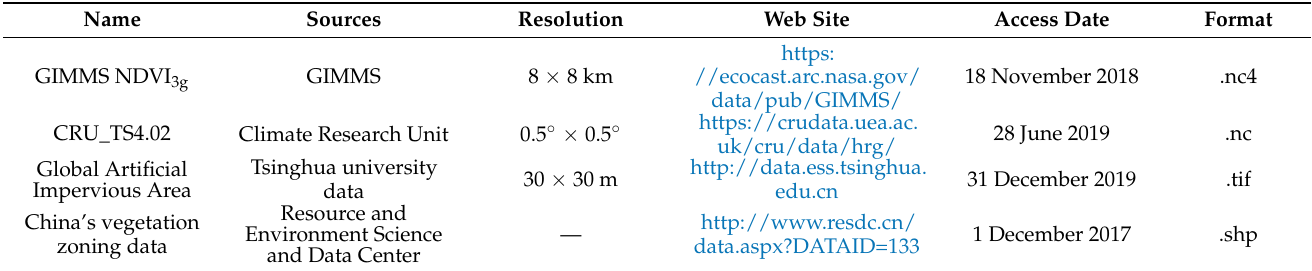
Table 1. The source of main data and related